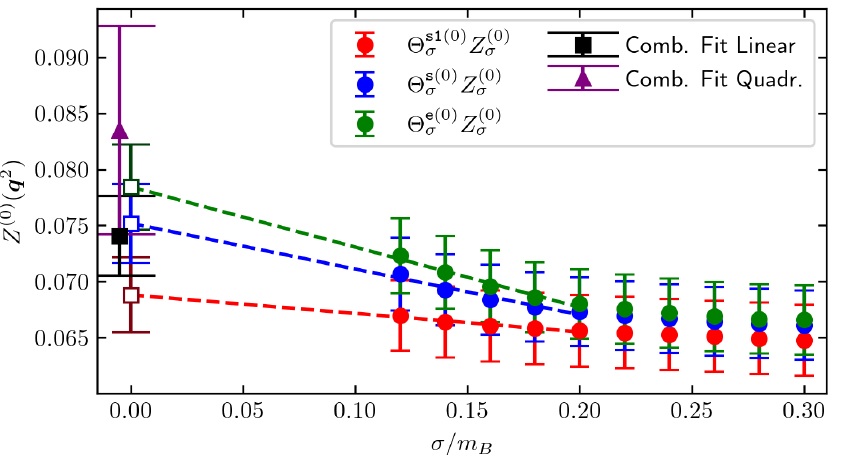
Figure 12 . Systematics associated with the σ → 0 extrapolation of Z (0) ( q 2 ) at | q | ’ 0 . 5 GeV, the same set of data shown in the top-left panel of figure 11. The unconstrained linear extrapolations of the different sets of data, corresponding to the three different smearing kernels, are shown together with the results of the combined linear extrapolation of the five points at the smaller values of σ (black point) and of the combined quadratic extrapolation including all ten values of σ (violet point). The black and violet points have been slightly displaced on the horizontal axis to help the